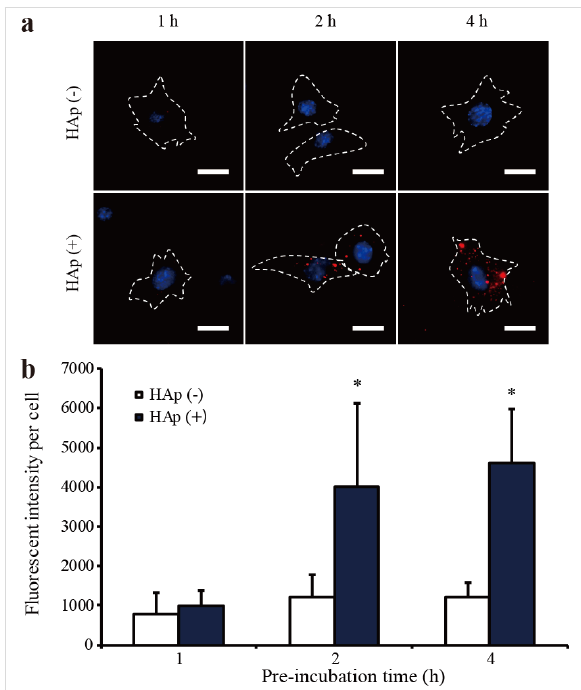
Figure 5: Macropinocytosis activity induced by HAp nanoparticles (1 µg/mL) in HL-1 cells. (a) HL-1 cells were pre-incubated in the pres- ence or absence of HAp for 1, 2, and 4 h, and then treated with TMR–dextran for 30 min. Nuclei were stained using Hoechst stain (blue). Scale bar: 10 µm. (b) Quantification of fluorescence intensity per cell number. Values are presented as the mean ± SD ( n = 25). * p <